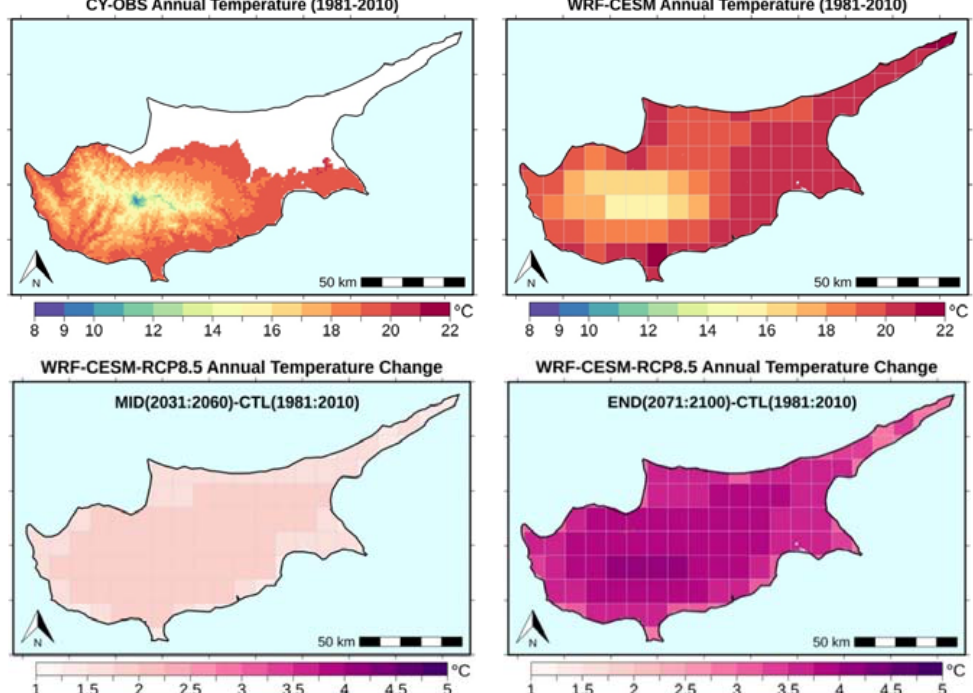
Figure 4. Observed ( top left ) and simulated ( top right ) average annual mean temperature for the period 1981 to 2010 and projected changes for the middle ( bottom left ) and end of the 21st century ( bottom right ).